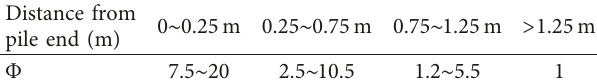
Figure 14: Comparison of the two methods. Table 6: Reference value of ϕ for different distance ranges from the pile end.